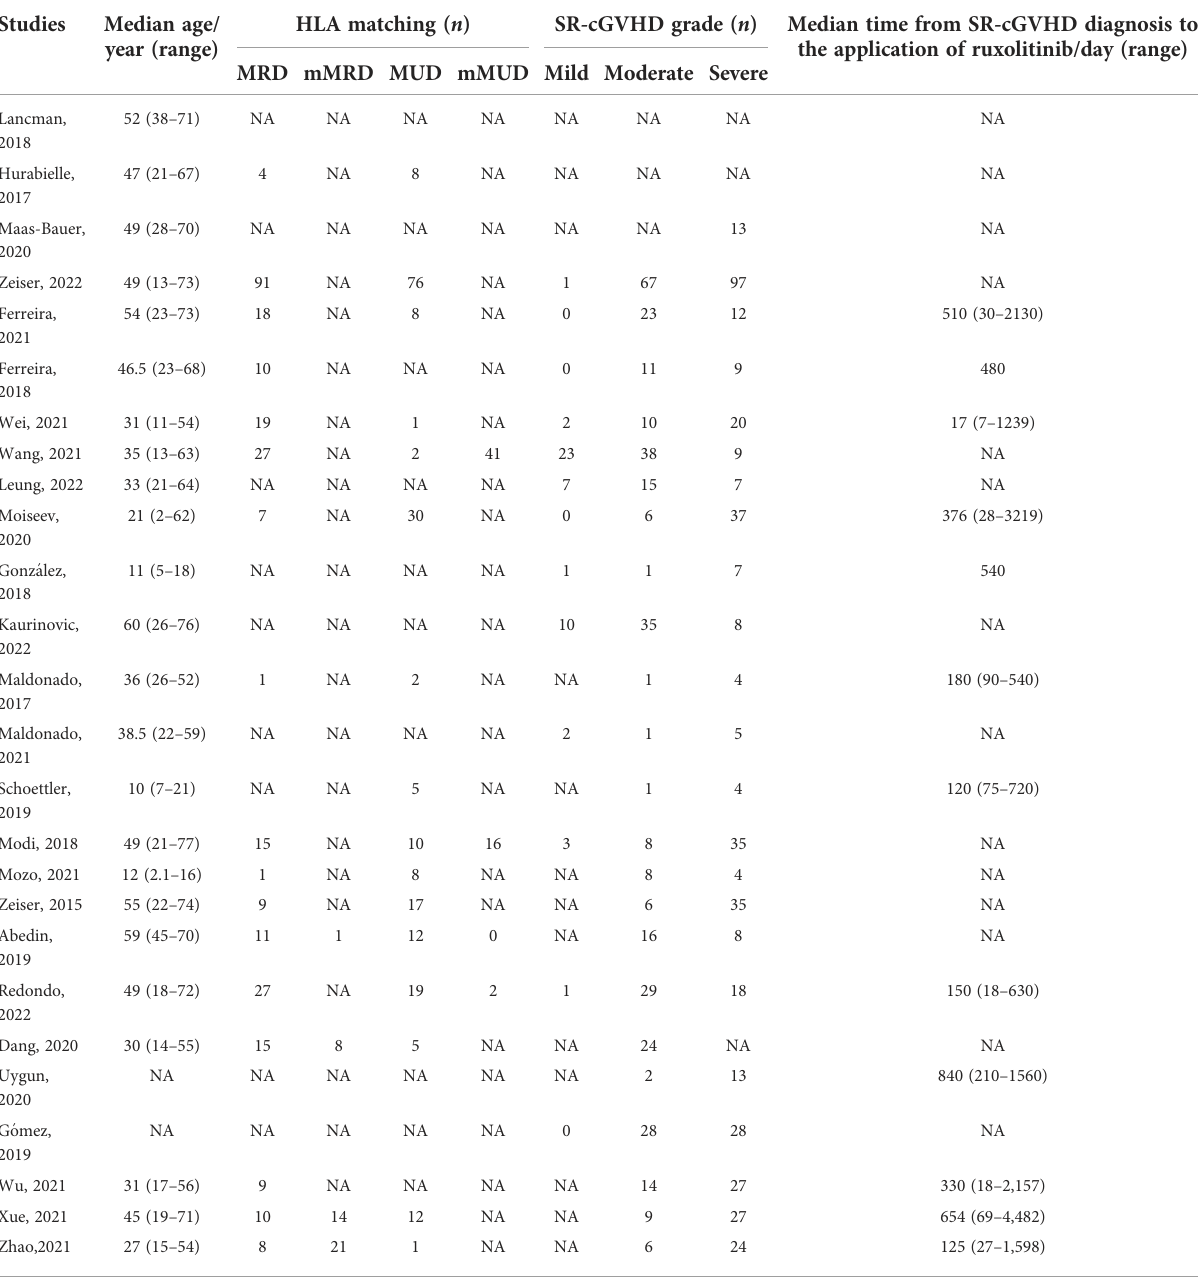
TABLE 2 Characteristics of 26 included studies (SR-cGVHD) *